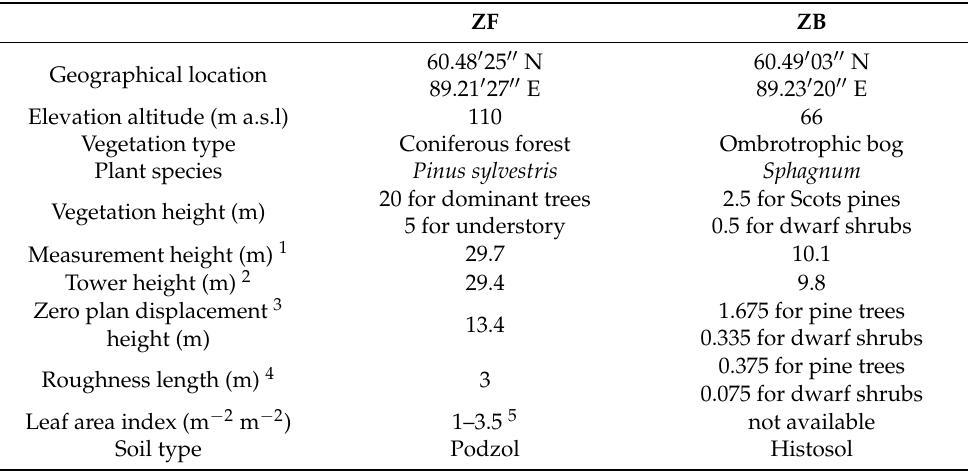
Table 1. Site characteristics of the forest and bog flux towers at